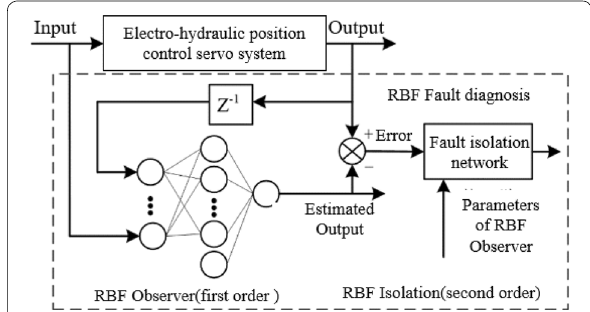
Figure 21 Fault diagnosis method based on a two-stage RBF neural